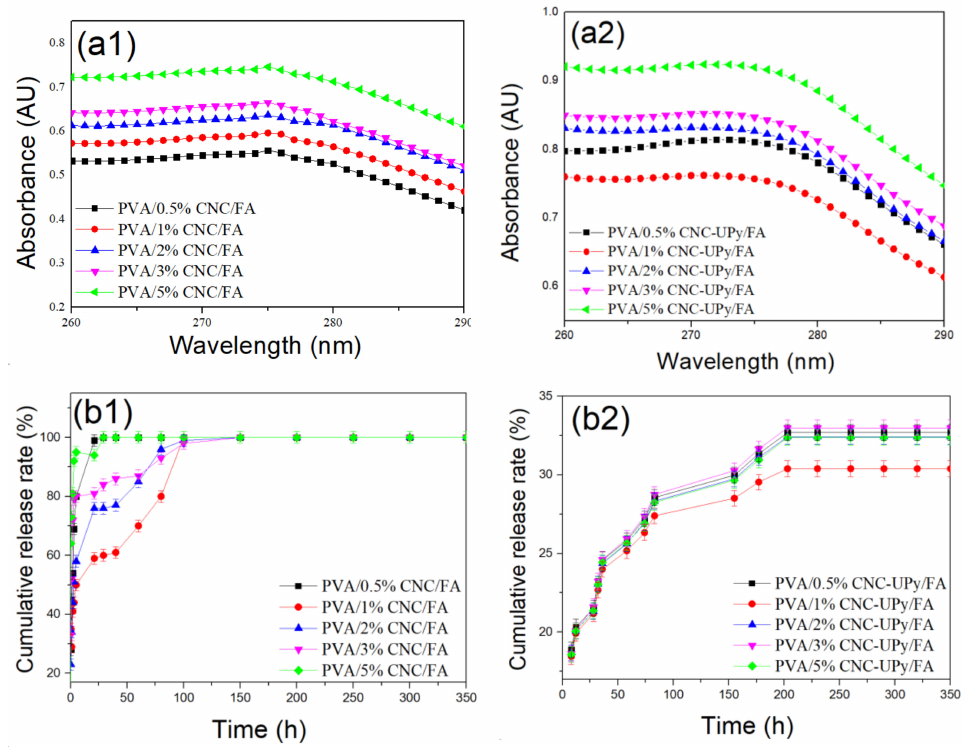
Figure 11. ( a1,2 ) UV spectra of di ff erent PVA composite hydrogels at 24 h,( b1,2 ) sustained release behavior of PVA composite